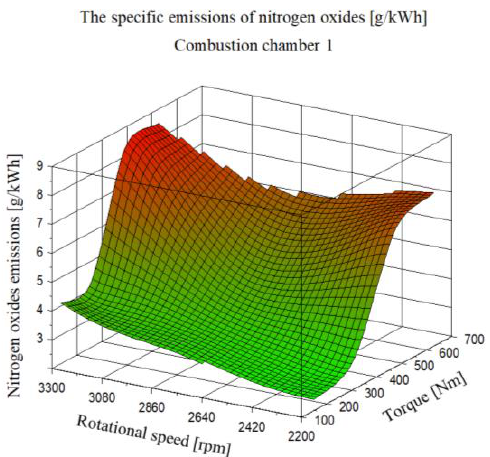
Figure 21. The nitrogen oxides specific emissions for the engine equipped with the combustion chamber 1.